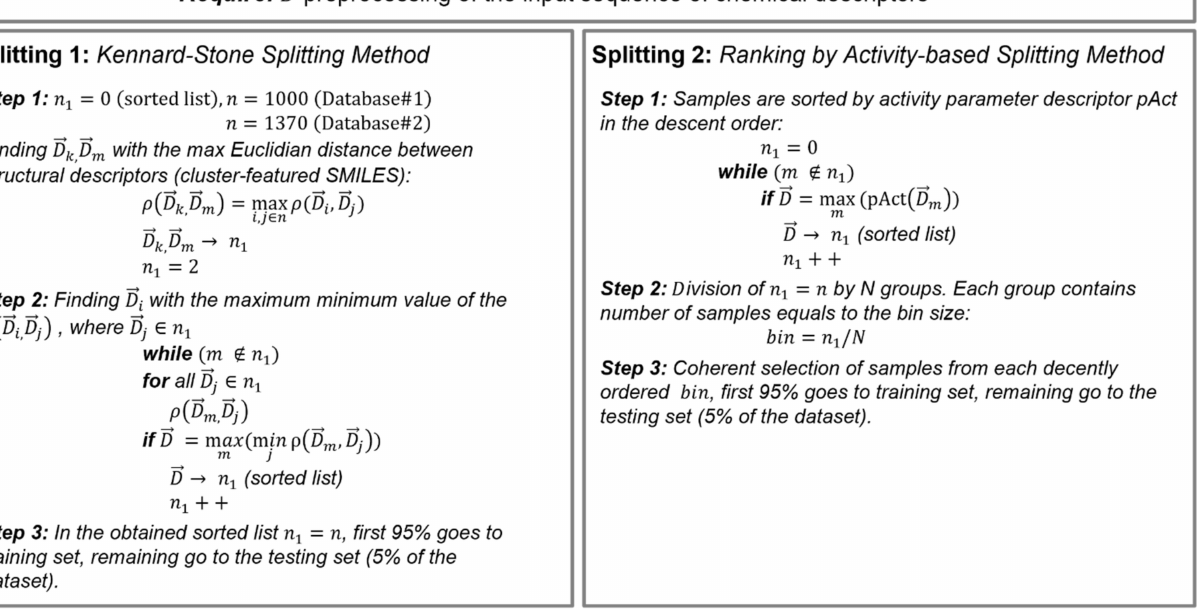
Figure 4. Pseudocode of the dataset partitioning splitting methods. (A) Train–test splitting using Kennard–Stone algorithm. (B) Ranking by activity train–test splitting algorithm. Due to the 5%/95% partitioning ratio with regard to the original dataset, we elaborated with the first n = 1000 (Dataset#1) and n = 1370 (Dataset#2) samples to have a feasible round number for the train–test